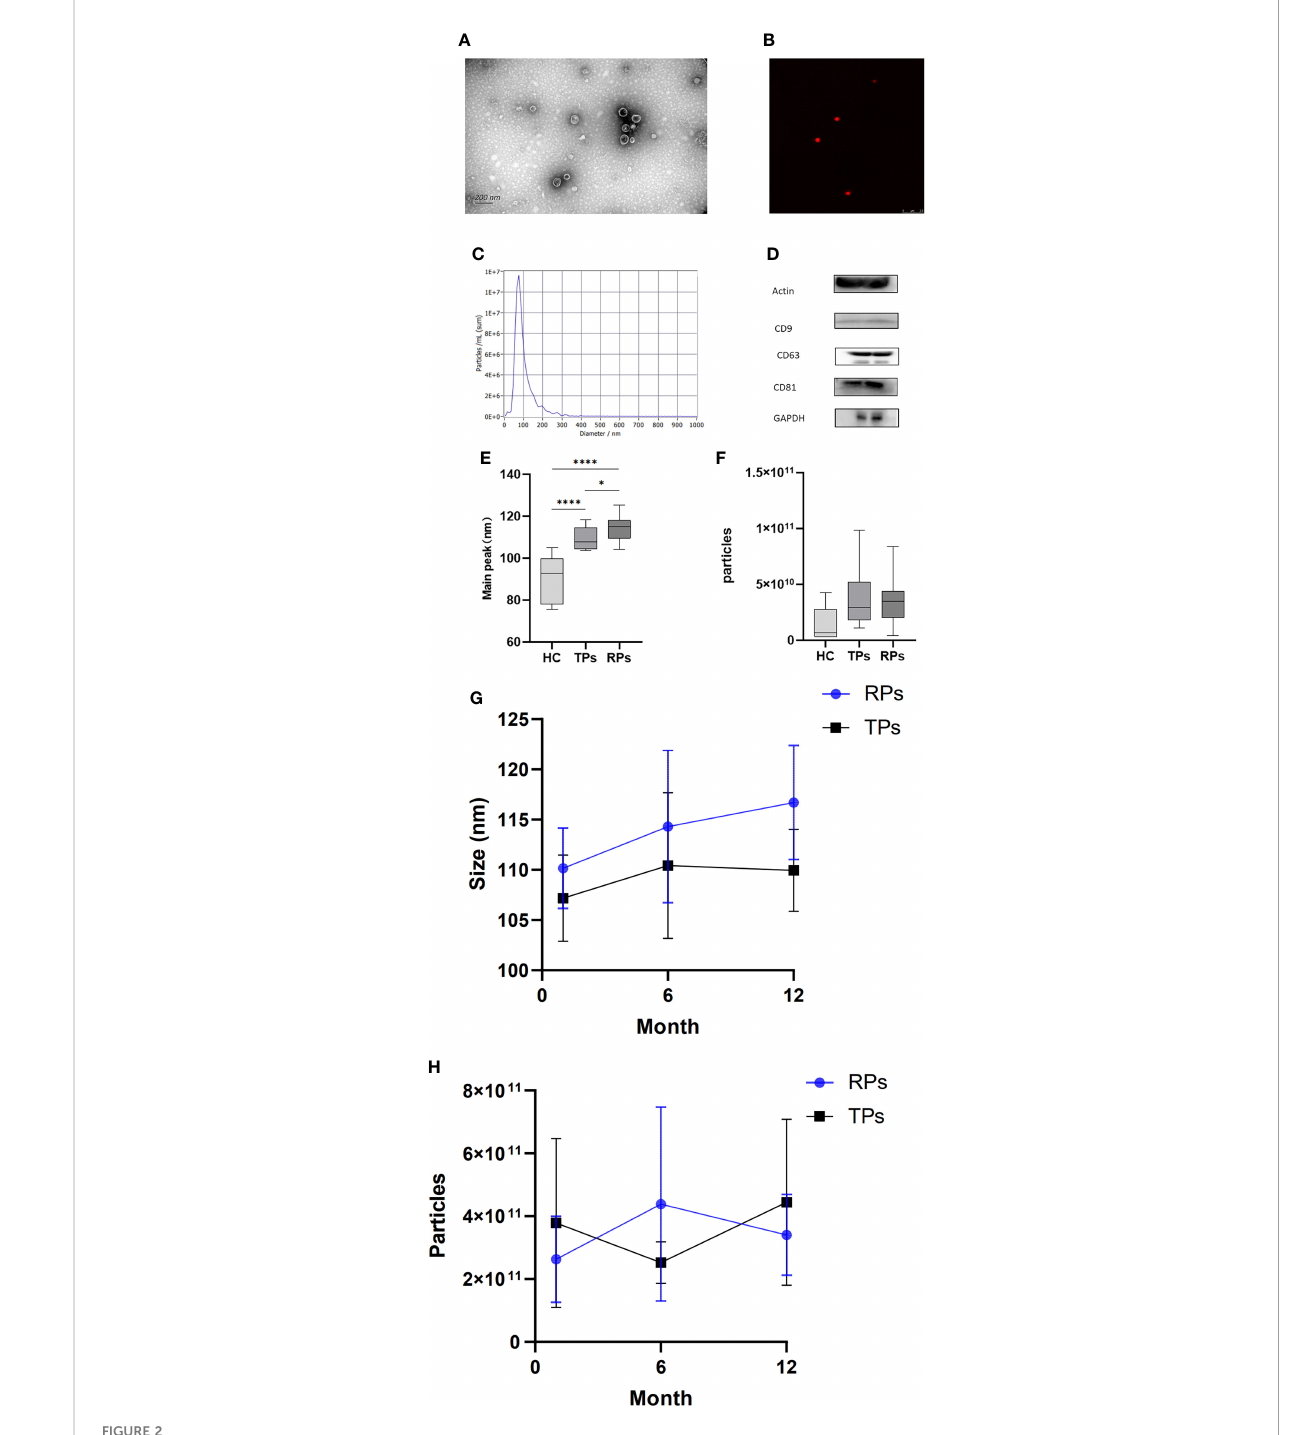
FIGURE 2 Basic characteristics and identi fi cation of exosomes in different disease progress groups. (A) Exosomes morphology analyzed by representative electron microscopy. Scale bar, 200 nm. (B) Ultrasensitive laser confocal microscopy was used to identify Exosomes (CD9-AF647). (c) NTA obtained the nanoparticle size distribution for plasma Exosomes. The particle size is between 30 and 150; the highest peak is observed at 70 nm. (D) Western blot analysis of actin, CD9, CD63, CD81, and GAPDH expression. (E, G) The peak size between HC, TPs, and RPs (e) and between month 1, 6, and 12 in TPs and RPs groups (g). (F, H) The concentration of Exosomes between HC, TPs, and RPs (f) and between month 1, 6, and 12 in TPs and RPs groups (h). * p<0.05,